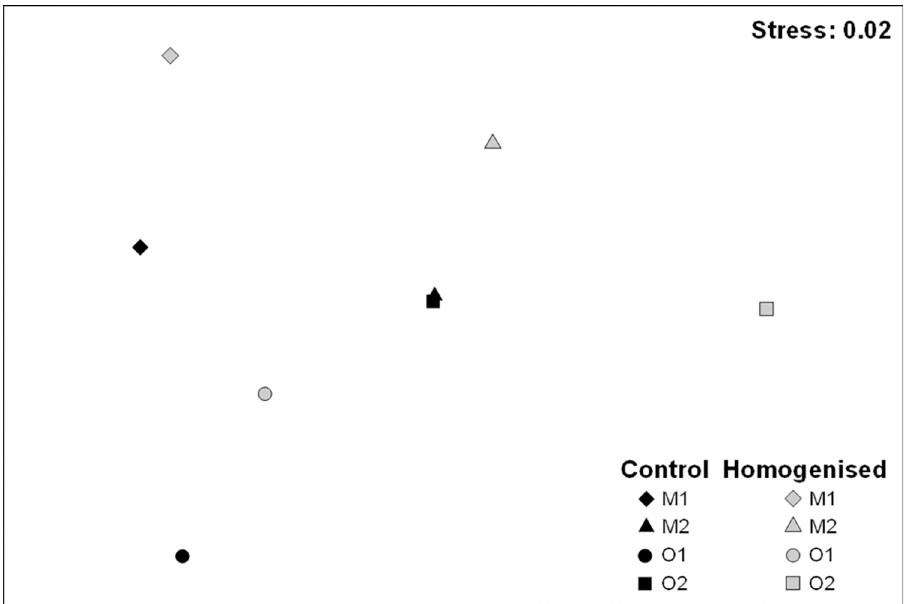
the differences between control and homogenised clumps in only a single site, namely Nucella lapillus and Dolichopodidae in M1, Patella depressa in O1 and Oligochaeta in O2. Most taxa showed higher abundance in homogenised clumps compared to the control ones (S1 Table). However, G . umbilicalis and I . pelagica were more abundant in the control clumps. Moreover, five taxa in M1 (i.e., Hyale juveniles, H . nilssoni/stebbingi , J . albifrons , S . monocu- loides , N . lapillus ) and Chironomidae in O1 were also more abundant in the control clumps (S1 Table).